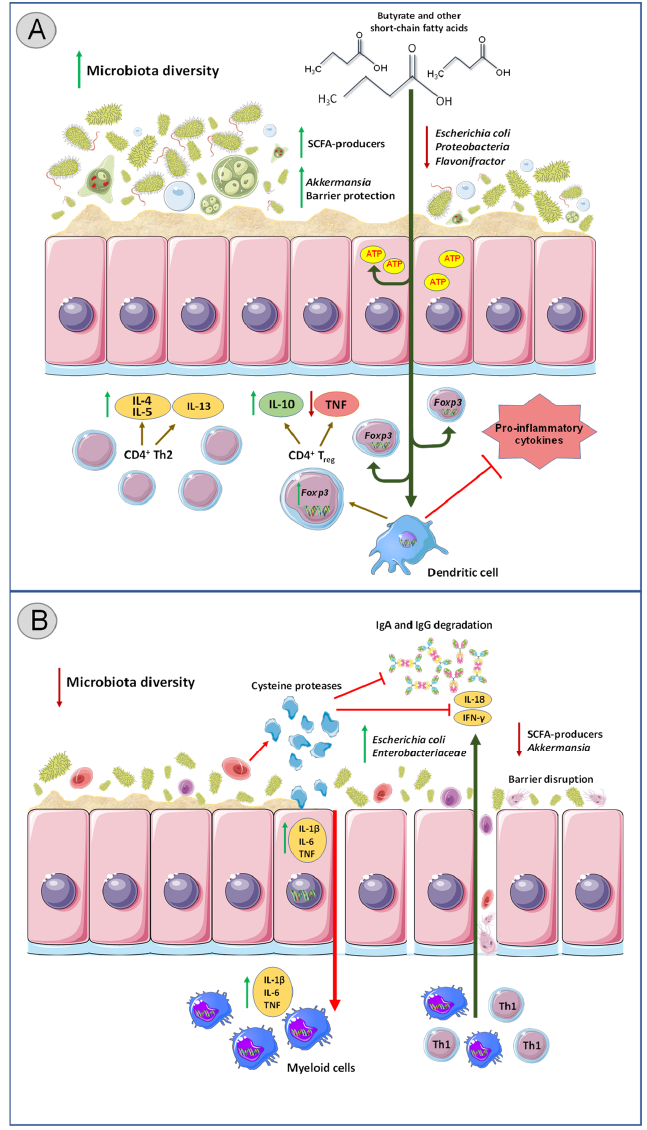
Figure 1. The impact of intestinal protozoa colonization on gut immunity and bacterial composition. ( A ) Colonization with commensal protozoa species (e.g., Entamoeba spp. besides Entamoeba histolytica ) leads to increased microbial diversity and remodeling of bacterial communities in the gut. SCFA (short-chain fatty acids) producers are enriched, and pathogenic bacterial species such as Escherichia coli and Proteobacteria are reduced. SCFAs in the intestinal lumen are absorbed by epithelial cells for energy production, while unmetabolized SCFAs enter the systemic circulation. Outside the gut, SCFAs facilitate generation of extrathymic Tregs via enhanced acetylation of Foxp3 locus in CD4 + T cells as well as directly affect gene expression in dendritic cells, thus prompting Treg differentiation and consequently IL-10 production. Colonization with commensal protozoa strains leads to polarization of T cell responses towards Th2-dominated profile characterized by IL-4, IL-5, and IL-13 secretion as well as downregulation of TNF. Overall, this results in decreased pro-inflammatory response within the intestines. ( B ) Colonization with pathogenic protozoa species (such as Cryptosporidium and Entamoeba histolytica ) can lead to decreased microbiota diversity, enrichment of pathogenic bacterial species, and a decline in abundance of beneficial bacteria. Cysteine proteases produced by pathogenic protozoa compromise the intestinal epithelial barrier by depleting colonic mucin and create gaps between colonocytes, enabling the parasites to breach the epithelial barrier and invade the tissue. Cysteine proteases also degrade IgA, IgG and IL-18, as well as inhibit Th1-type responses. Pathogenic protozoa also upregulate IL-1B, IL-6, and TNF in the intestines. Overall, these triggers aggravated inflammatory response within the gut. SCFA: Short chain fatty acid, IL: Interleukin, Tregs: T regulatory Th: T helper, TNF: tumor necrosis